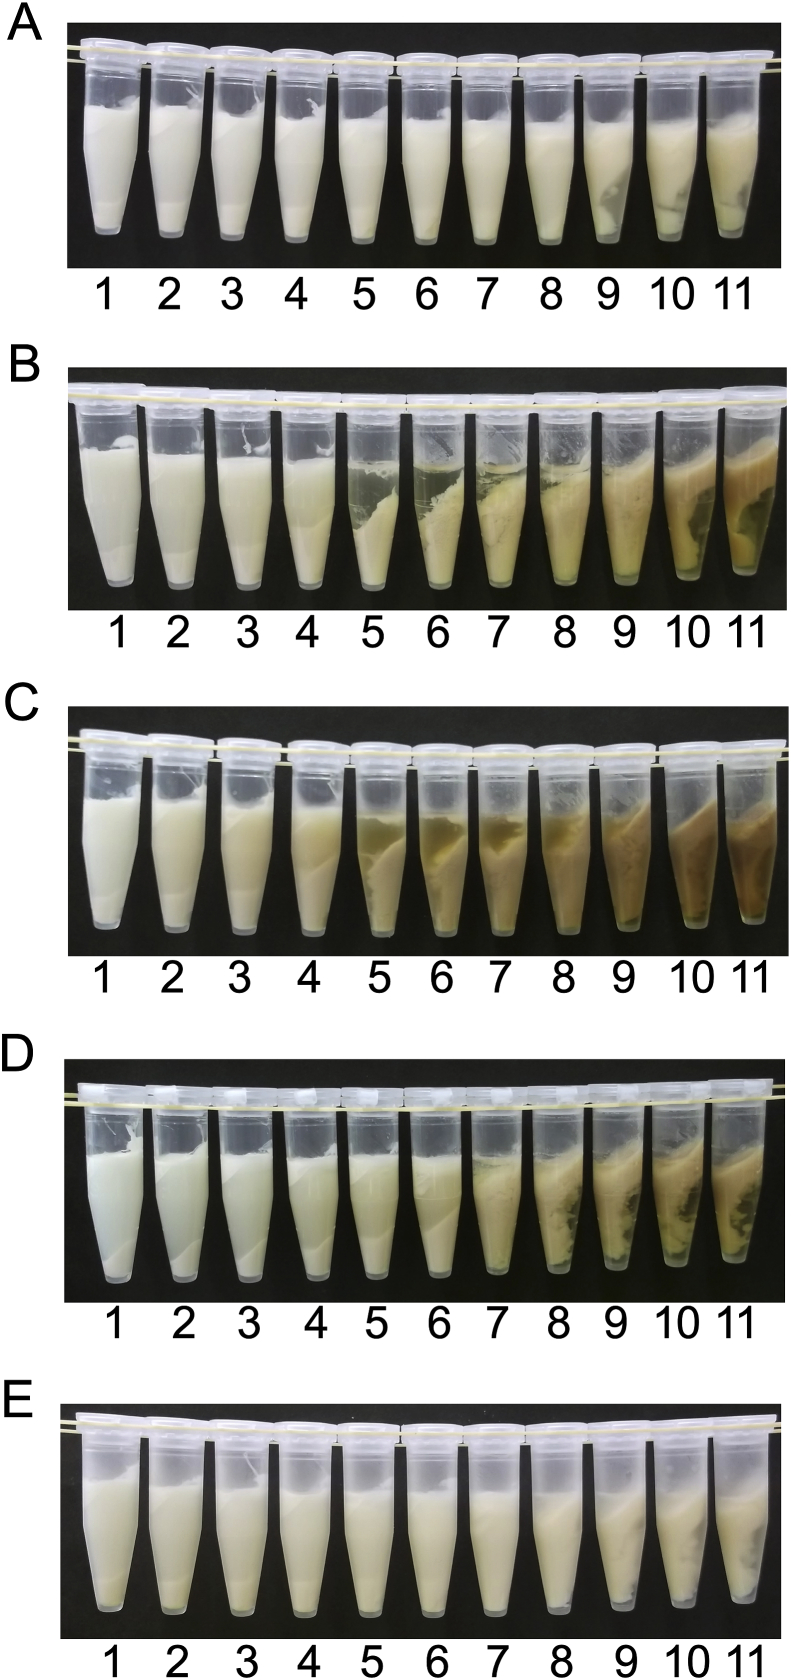
Concentration-dependent protein aggregation by honey. Acacia (A), coffee (B), buckwheat (C), bindweed (D), and blended (E) honeys at different concentrations were added to soymilk at a final concentration of 0% (1), 5% (2), 10% (3), 15% (4), 20% (5), 25% (6), 30% (7), 35% (8), 40% (9), 45% (10), and 50% (11).